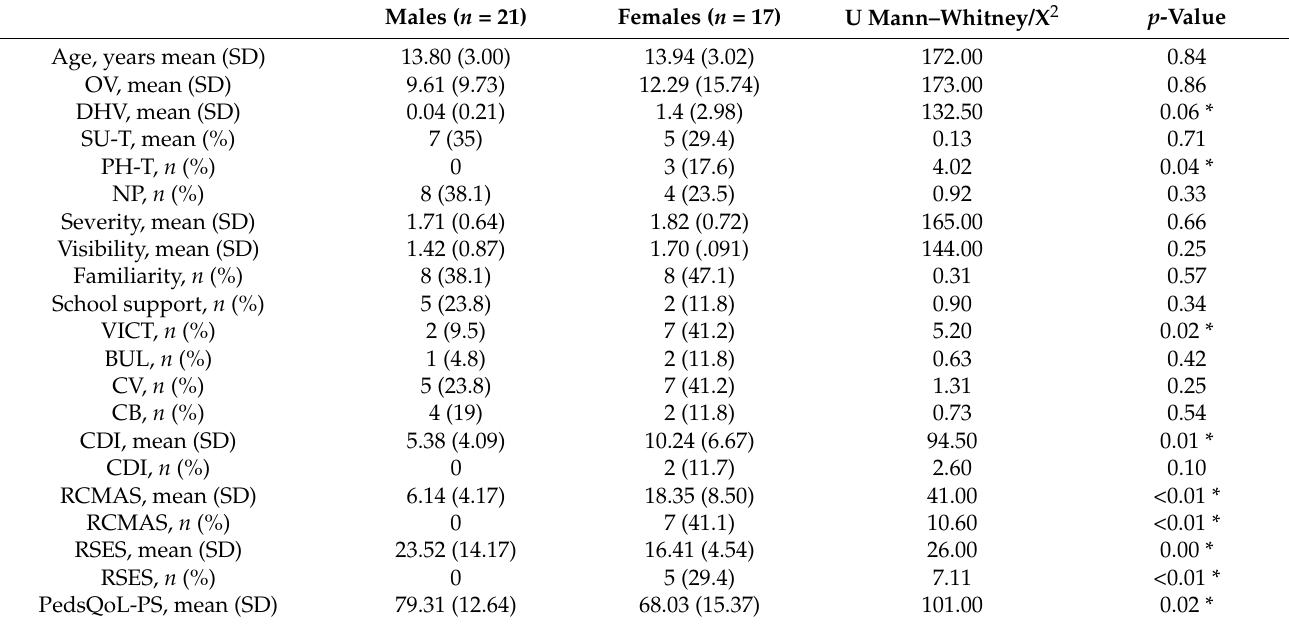
Table 1. Comparisons of demographic, clinical, and behavioral variables between males and females. Males ( n = 21) Females ( n = 17) U Mann–Whitney/X 2 p